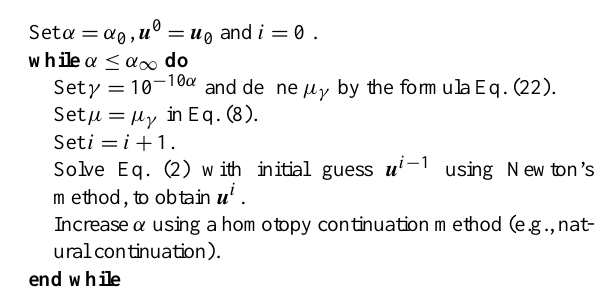
Algorithm 1 Homotopy continuation on regularization